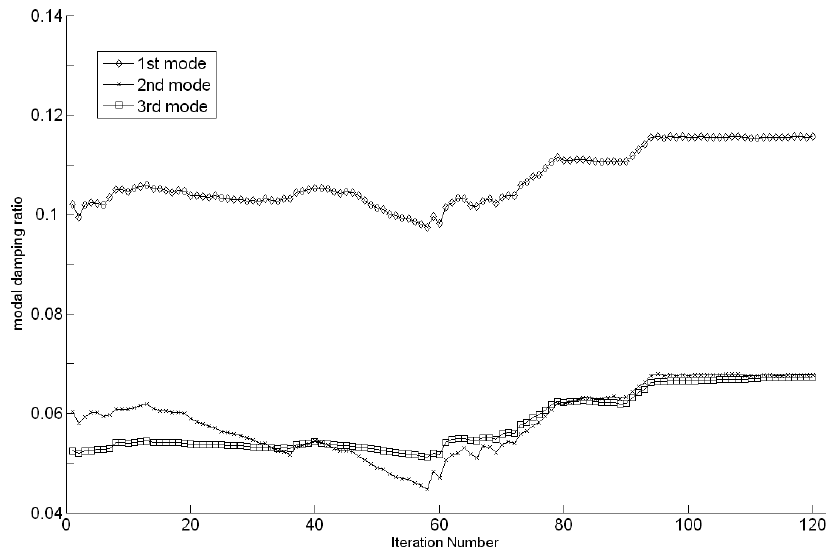
Fig. 25. Iteration histories for different modes vf =